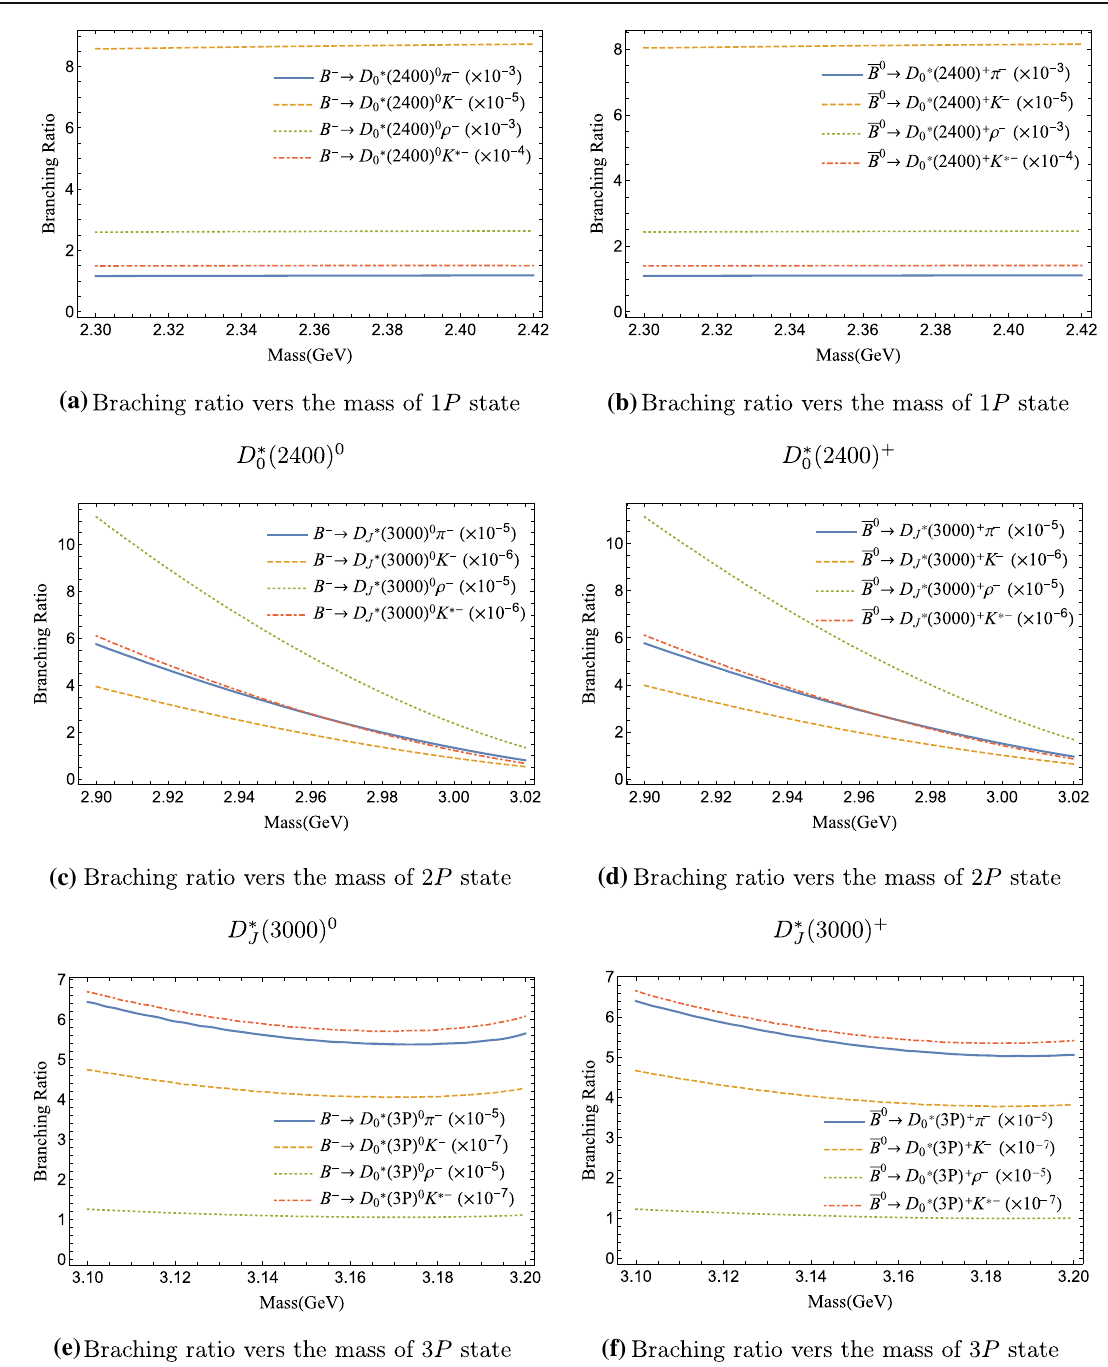
Fig. 7 The branching ratios of non-leptonic production of D ∗